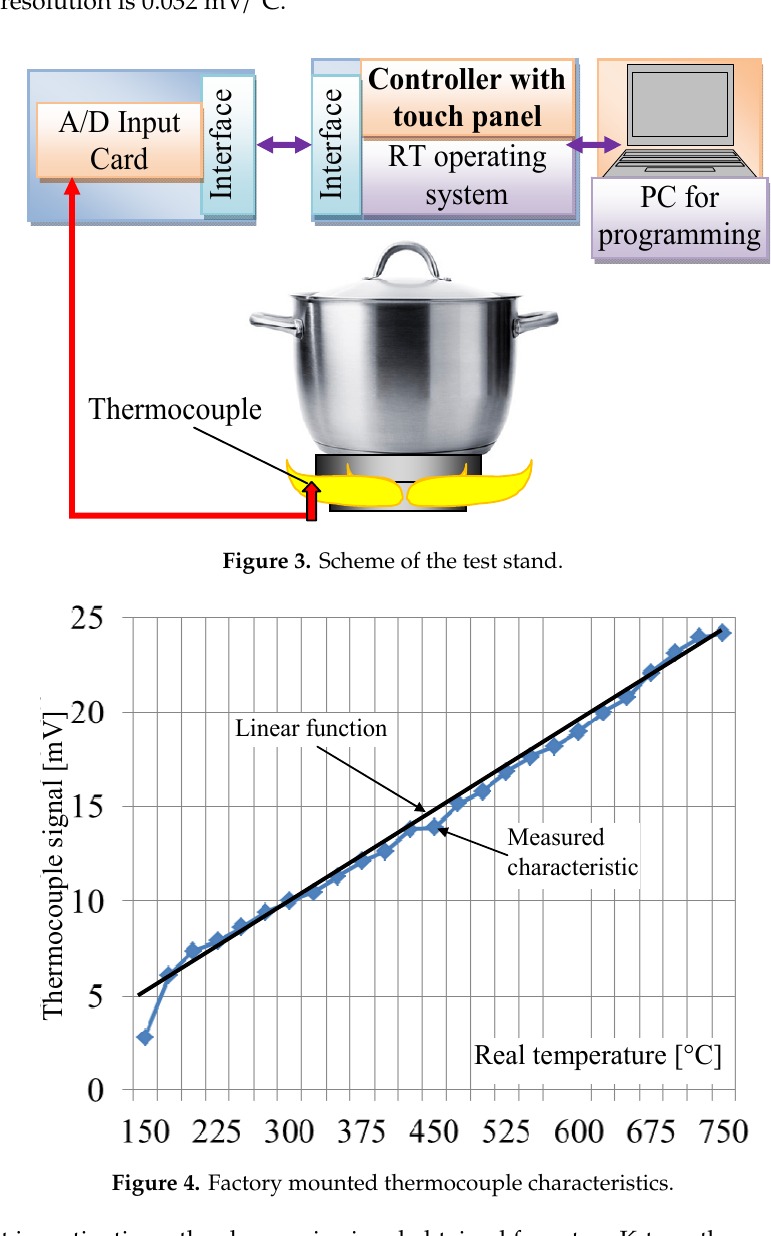
Figure 4. Factory mounted thermocouple characteristics.